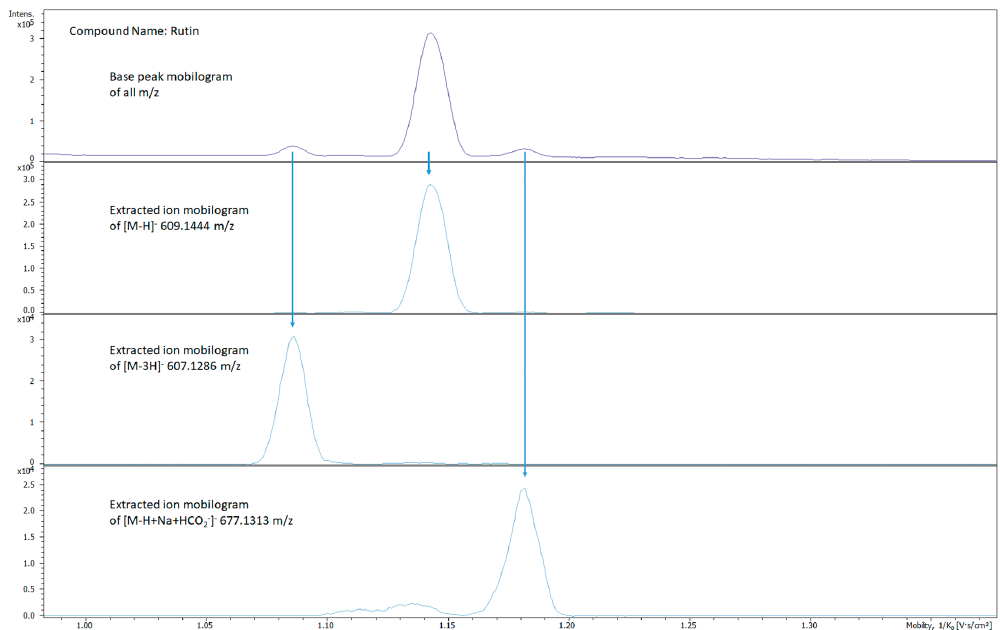
Figure 5. Comparison of the base peak and extracted ion mobility spectra of rutin ions demonstrating the complexity of an ion mobility spectrum that can result from a single compound. TIMS was able to separate three prominent ions present. The top BPM shows all the ions and their relative intensities. The arrows show how the BPM spectrum corresponds with the EIM spectra. The three ions present are: [M-H] – 609 m/z, [M-3H] – 607 m/z, and [M-H+Na+HCO 2– ] – 677 m/z.